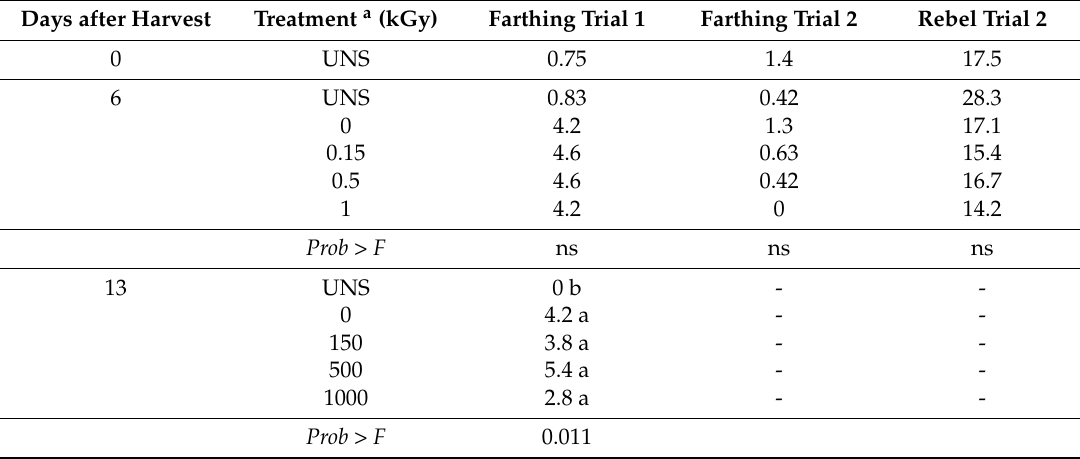
Table 4. Postharvest disease incidence, in percent, on ‘Farthing’ and ‘Rebel’ blueberry fruit subjected to Electronic Cold-Pasteurization TM 6 or 13 days after treatment plus 4 days at room